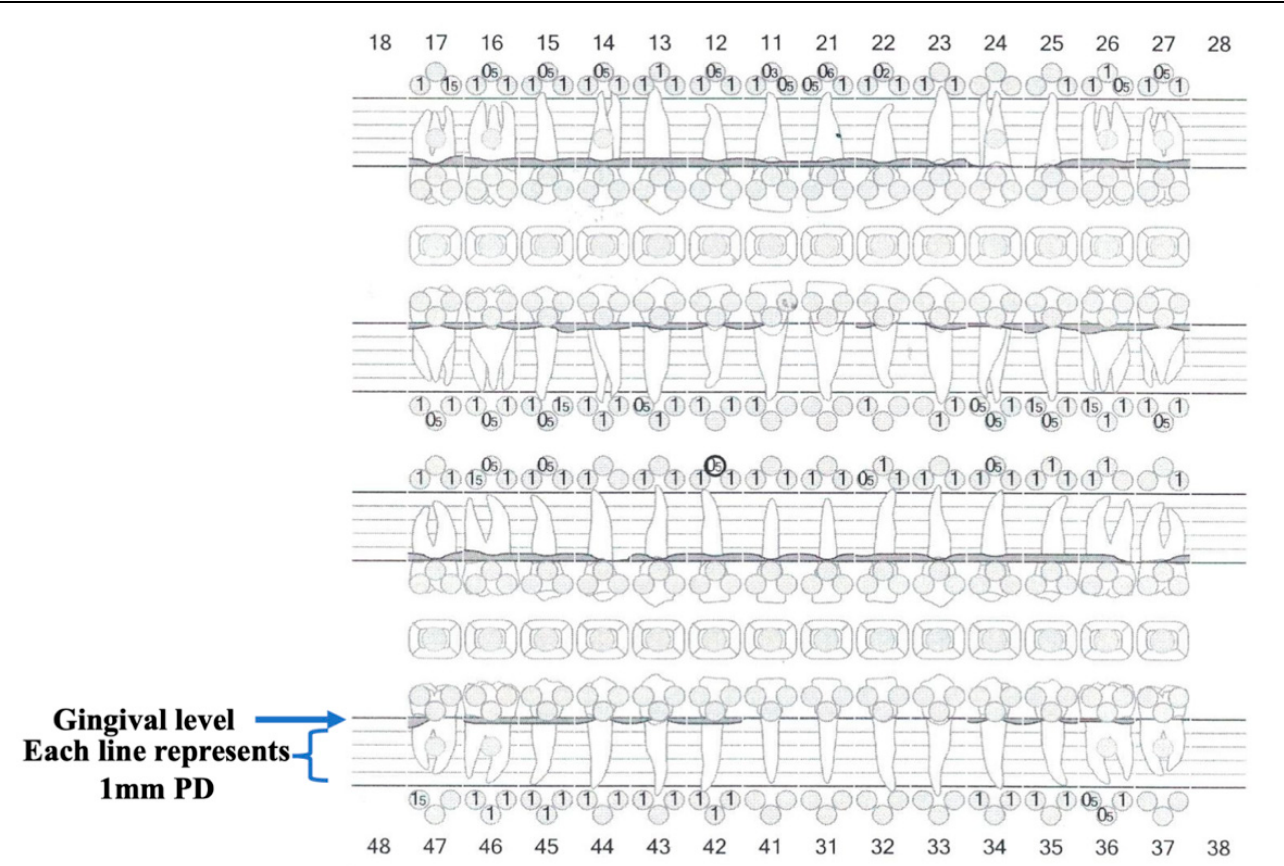
and #21, and #12 and #22, respectively. Photo ( B ) shows a great improvement in the gingival zeniths of upper incisors at six months, compared to those taken pre-operatively photo ( A ).